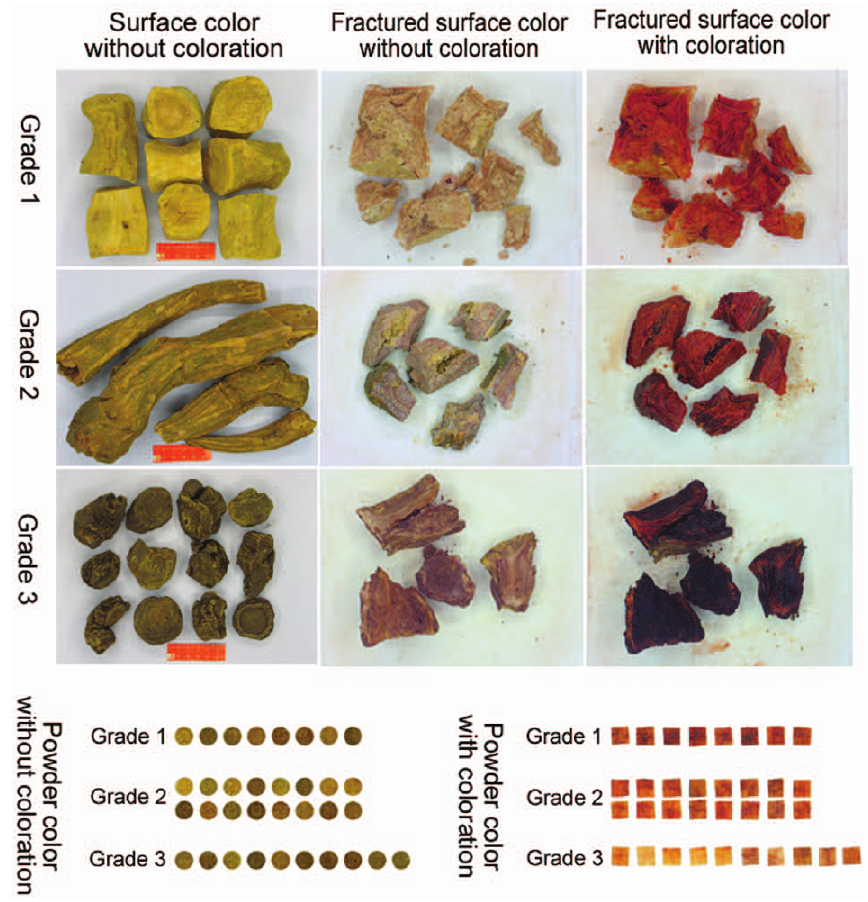
Figure 3. Representative images of rhubarb samples of different grades.